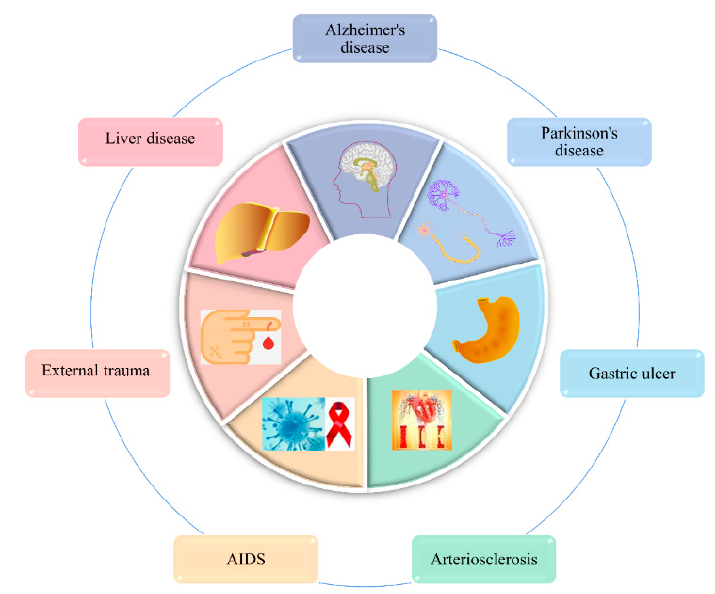
Figure 7. Therapeutic effects of edible insects on several common diseases.